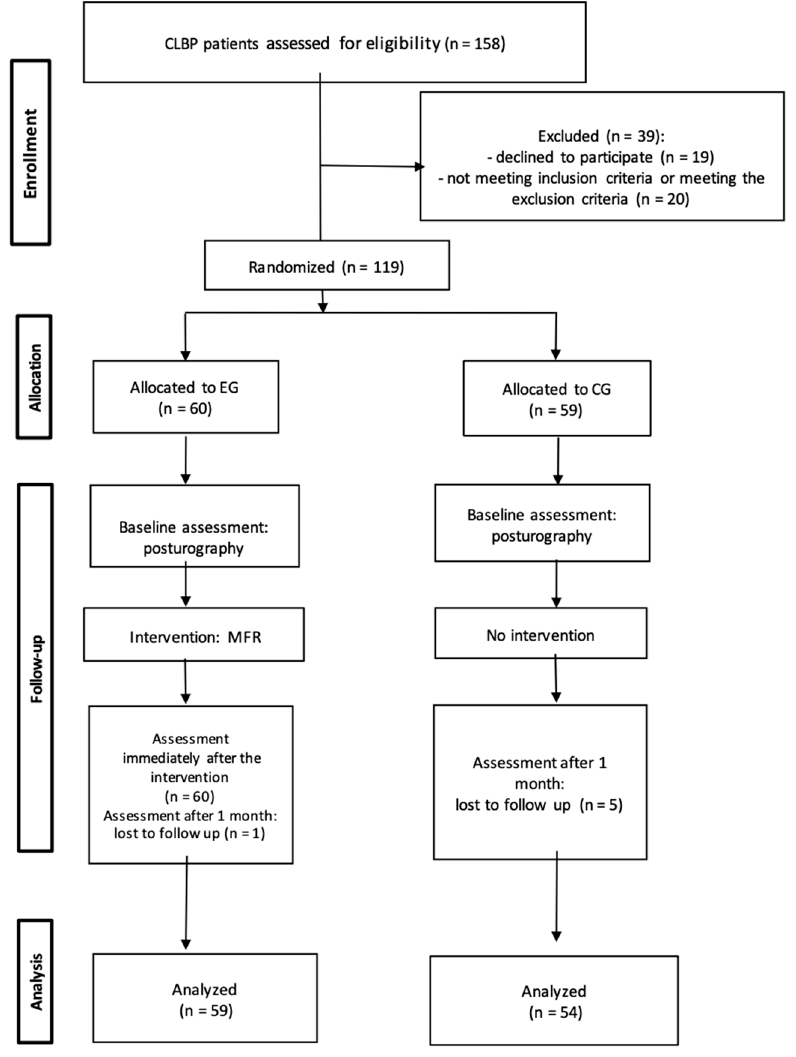
Figure 1. Study flowchart [34]. CLBP—chronic low back pain; EG—experimental group; CG—control group; MFR—myofascial release.